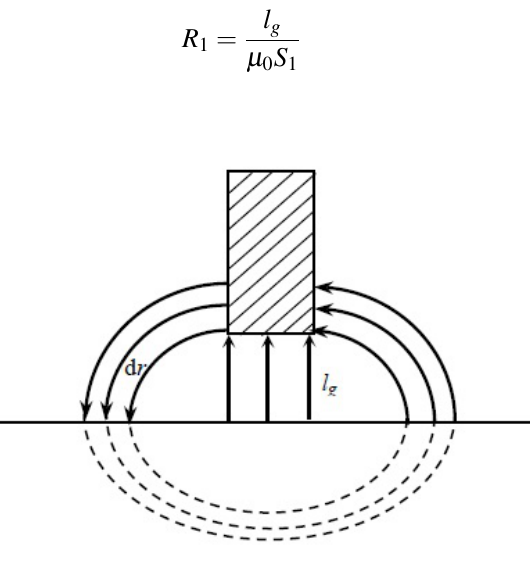
Fig. 6 Magnetic force line